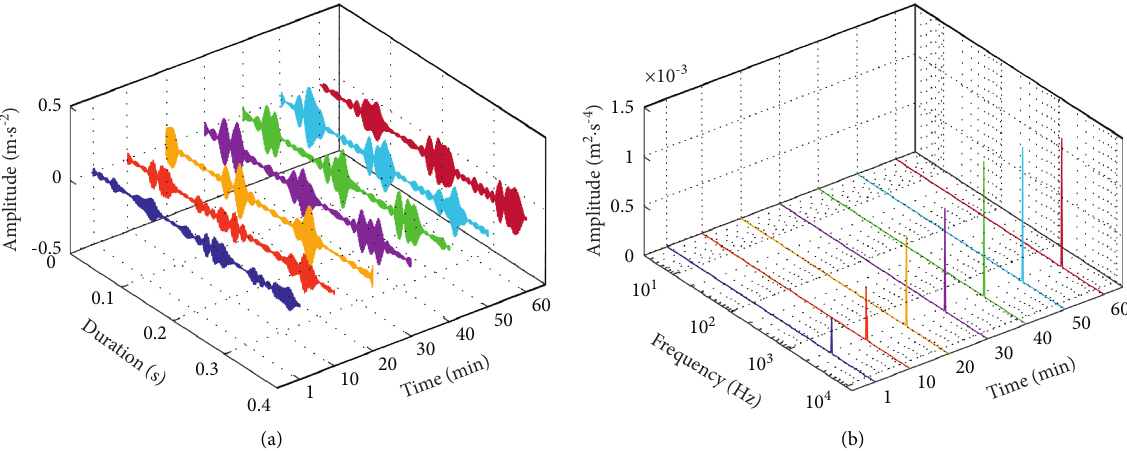
Figure 8: The waveform and power spectrum of the FIV signals under lubricated condition at different moments: (a) the time-domain waveform; (b) the power